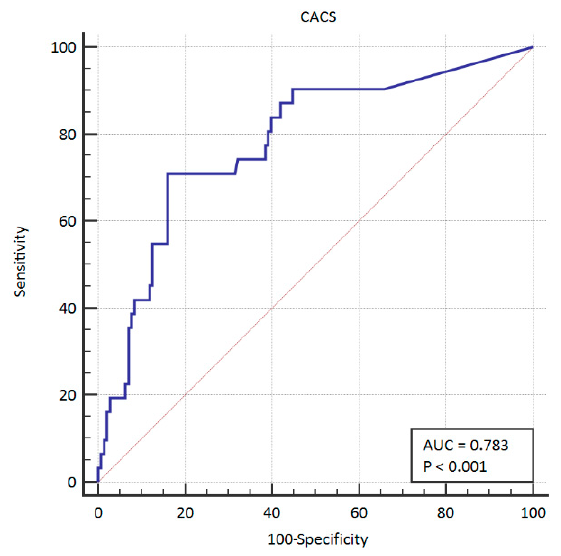
Figure 1. ROC curve for CACS in PCI. ROC: receiver operating characteristics; PCI: percutaneous coronary intervention.